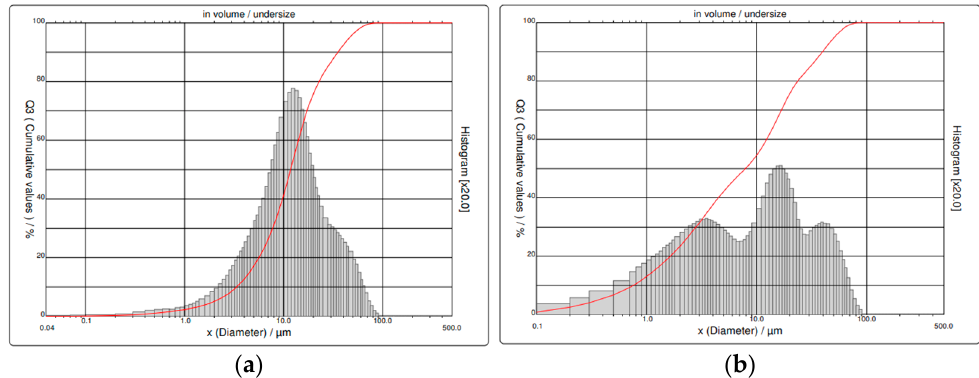
Figure 1. Particle distributions of ( a ) dried concrete sludge and ( b ) cement.